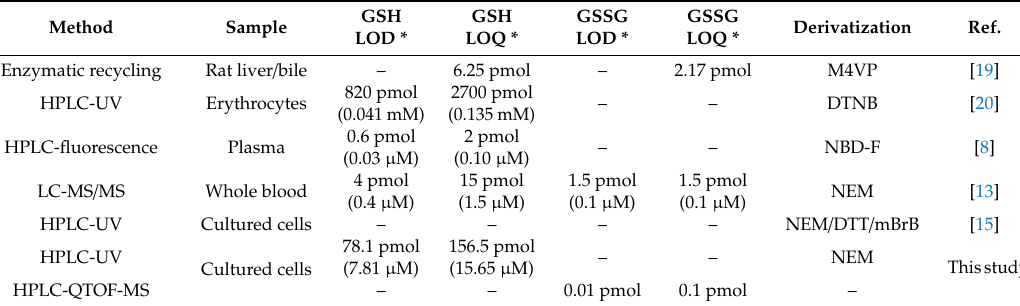
Table 1. Comparison of methods reported for the determination of GSH and